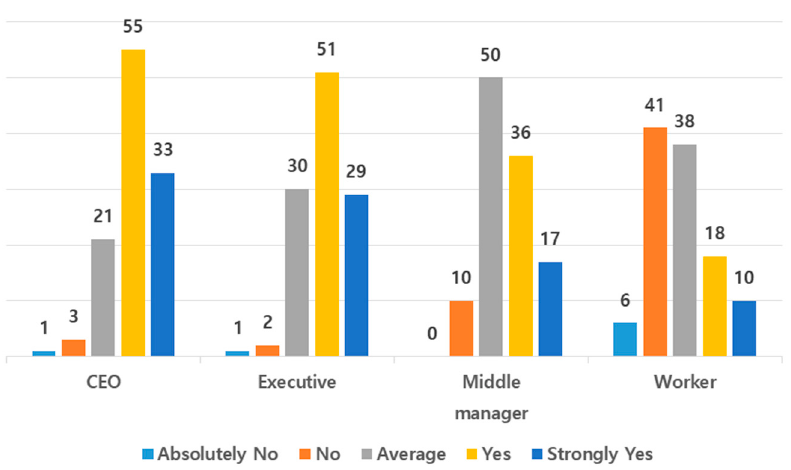
Figure 11. Organization members’ willingness to promote smart factory.